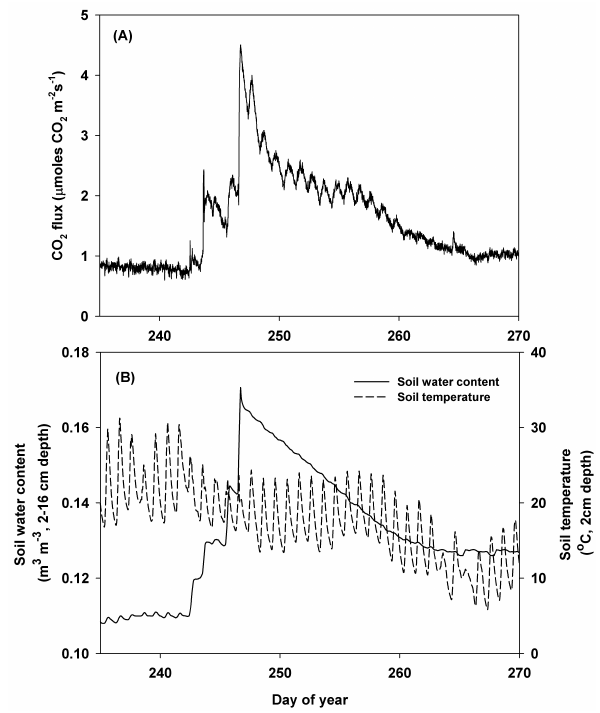
Fig. 2. High temporal resolution (hourly data) of soil CO 2 flux dy- namics before and after a rewetting event (A) ; and soil water content (2–16cm depth) and soil temperature (2cm depth) dynamics during the same dates of the soil CO 2 flux measurements (B) . Measure- ments were done during the year 2008 at the San Jacinto Mountains James Reserve, CA, USA (Vargas et al.,